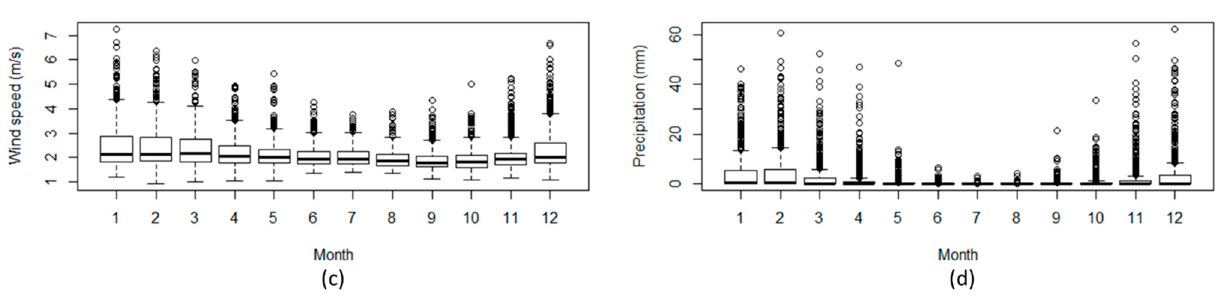
Figure 9. Median, standard deviation, 95% confidence interval, and outliers of monthly values of ( a ) temperature (C), ( b ) relative humidity (%), ( c ) wind speed (m/s), and ( d ) total daily precipitation (mm) in Lebanon for the period 2001–2020.